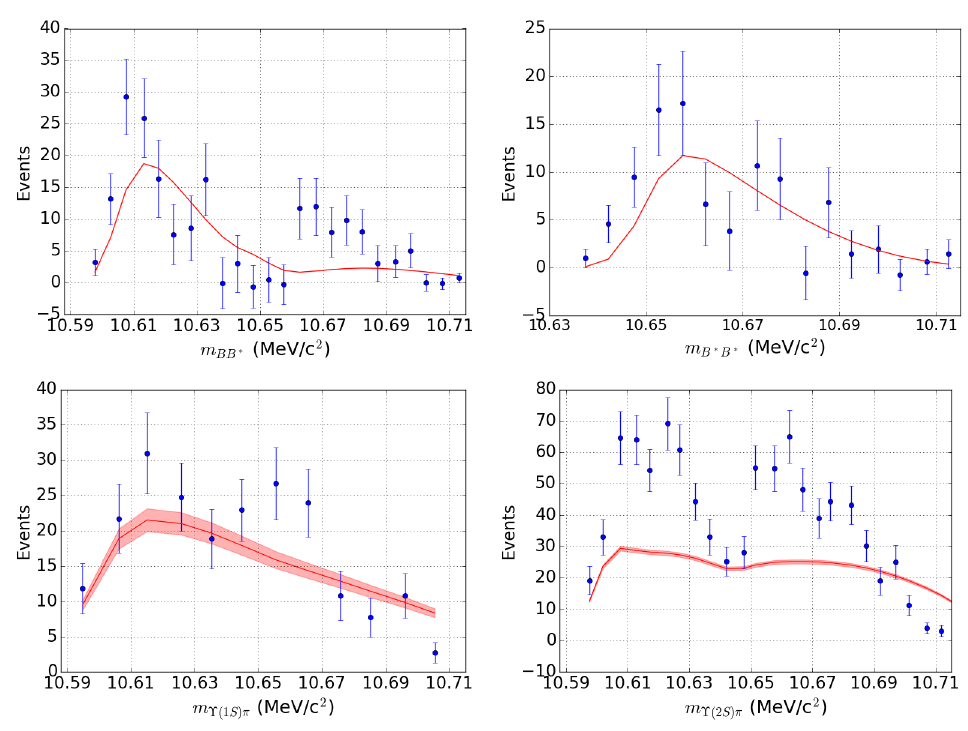
Figure 3: Line shapes for different channels. Experimental data from Refs. [ 4,5,37 ]